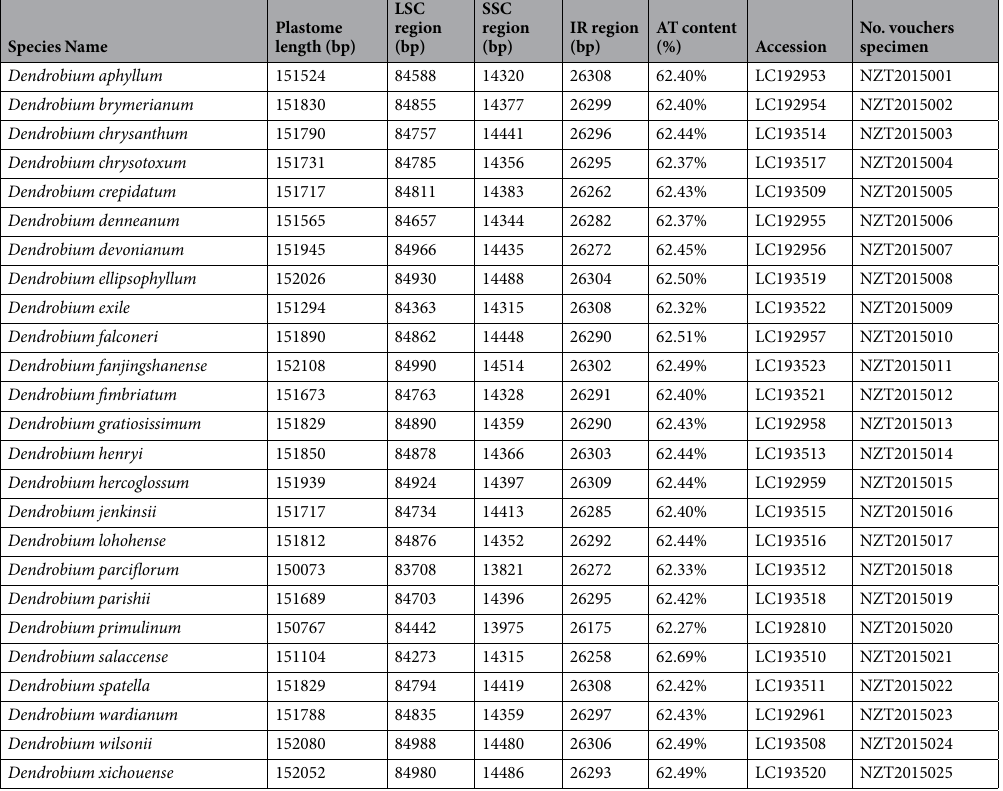
Table 1. Characteristics of the 25 newly sequenced Dendrobium